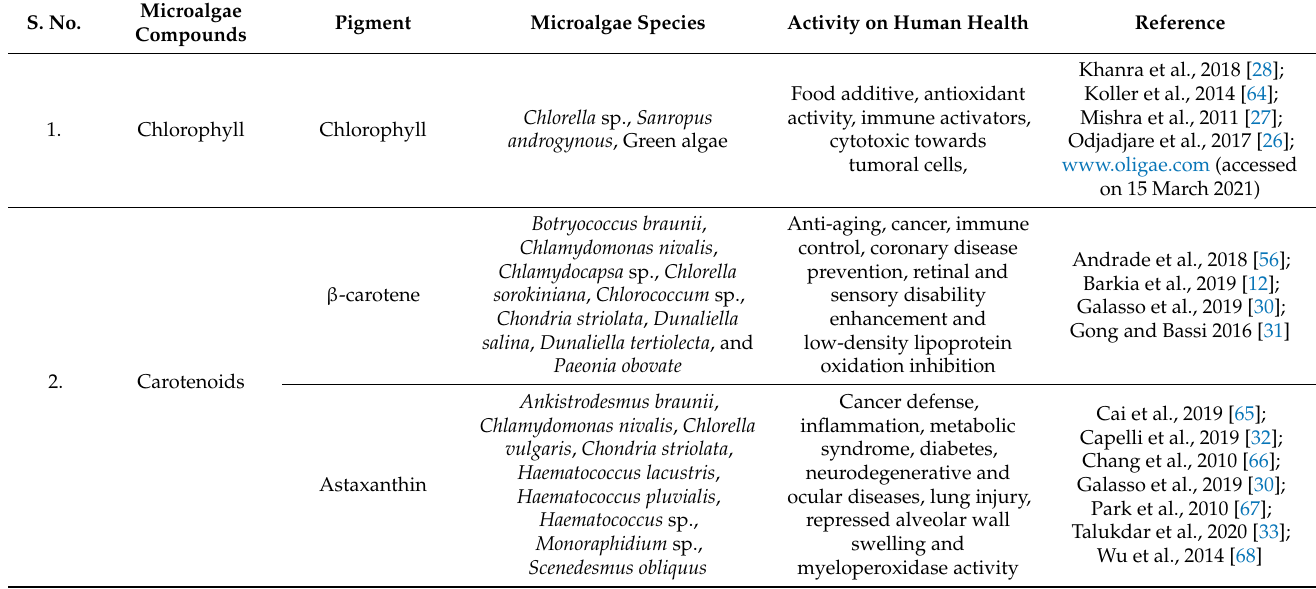
Table 1. Microalgae bioactive metabolites and producers for human